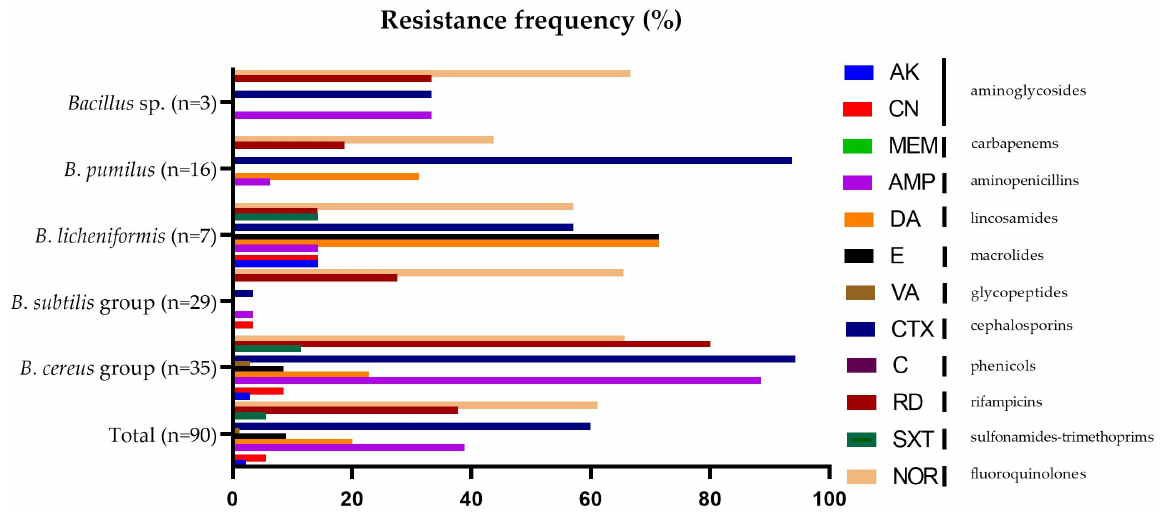
Figure 2. Antimicrobial resistance frequency (%) for the studied Bacillus strains ( n = 90) isolated from raw milk. The isolated strains belonged to the following groups: Bacillus sp., B . subtilis group, B . cereus group, or/and represented species B . licheniformis and B . pumilus . Abbreviations: CN—gentamicin,